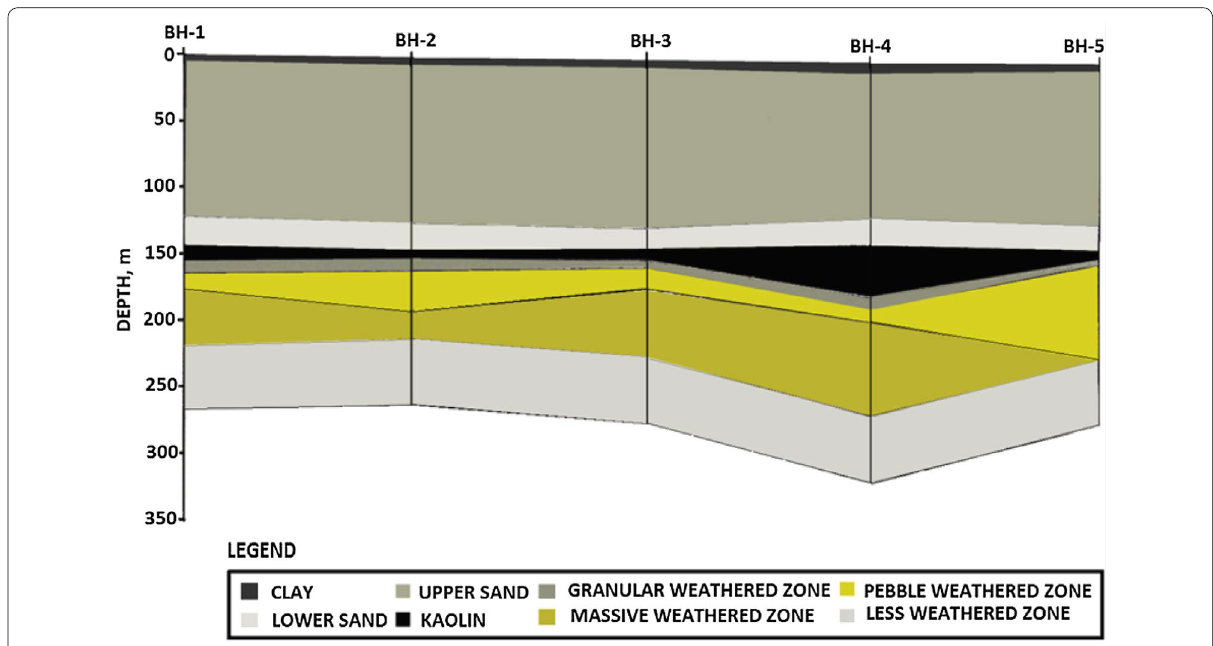
Fig. 3 Geological cross section across the MHRMP boreholes [Modified after Rahman